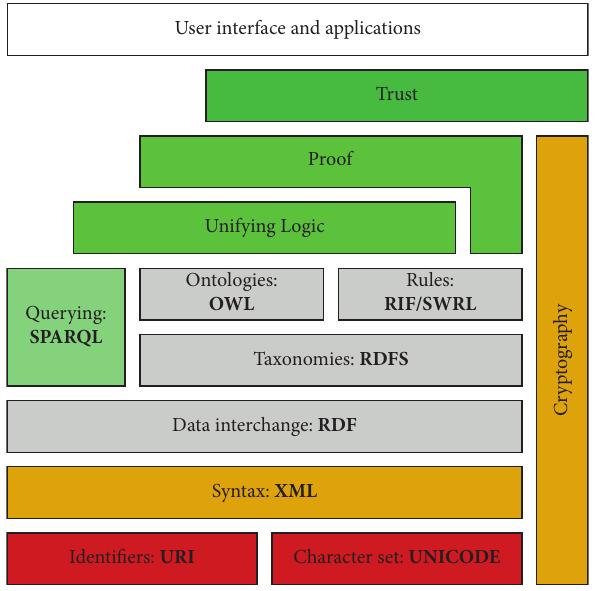
Figure 6: The Semantic Web Stack [36].